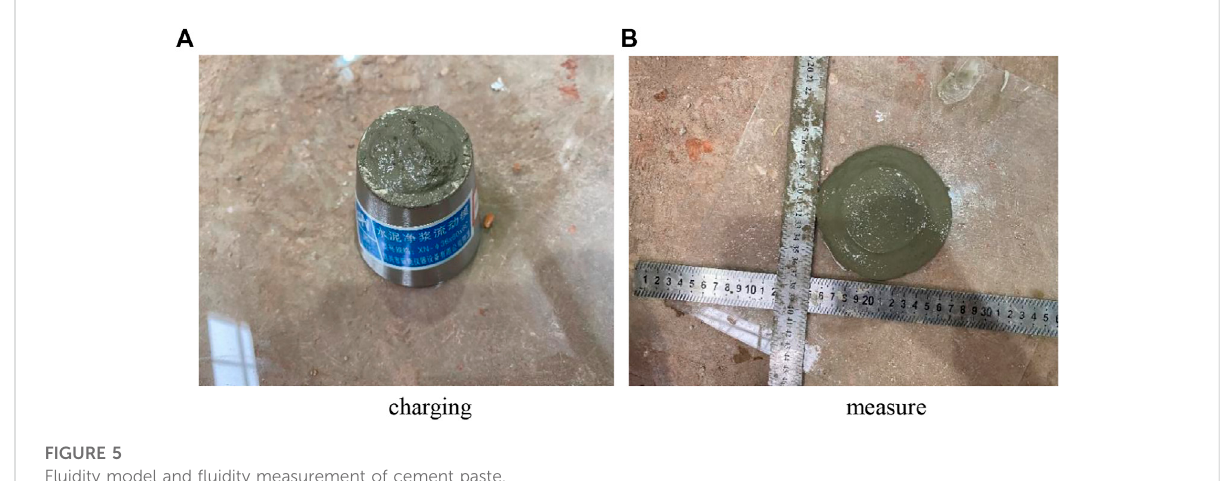
FIGURE 5 Fluidity model and fl uidity measurement of cement paste.